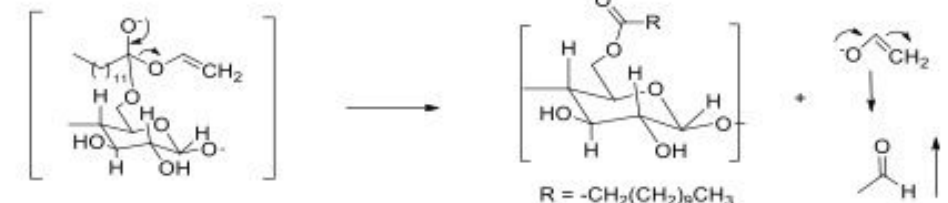
Figure 1. Representation of the steps of starch esterification mechanism with vinyl